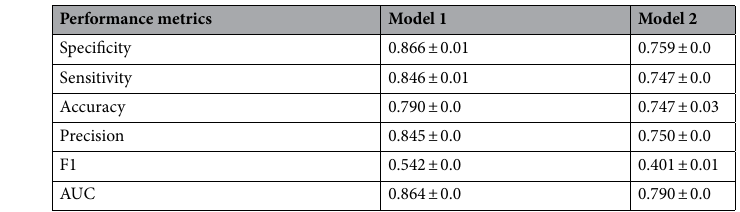
Table 4. Performance of the two ML models in predicting one-year mental health deterioration as outcome (mean ± SD). Models 1 and 2 are identical with the exception that Model 1 includes HADS Anxiety, HADS Depression, and Global Quality of Life ratings at M0 and M3 as